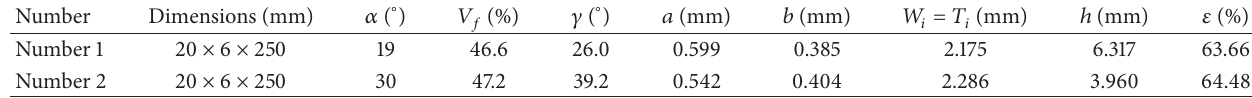
Table 2: Braiding parameters of specimens and structural parameters of unit cell model.